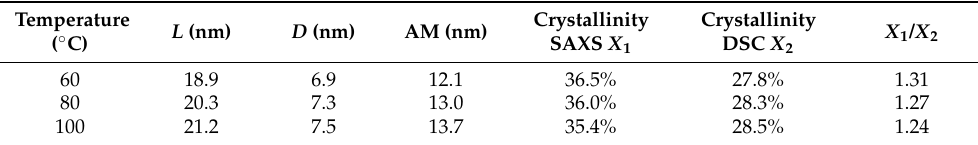
Figure 2. DSC heating curves of the PLLA/TAIC (60/40) blend after complete melt crystallization at the indicated temperatures. Table 1. Long period, thickness of lamellae, amorphous layer, crystallinity from SAXS and DSC upon melt crystallization at the indicated